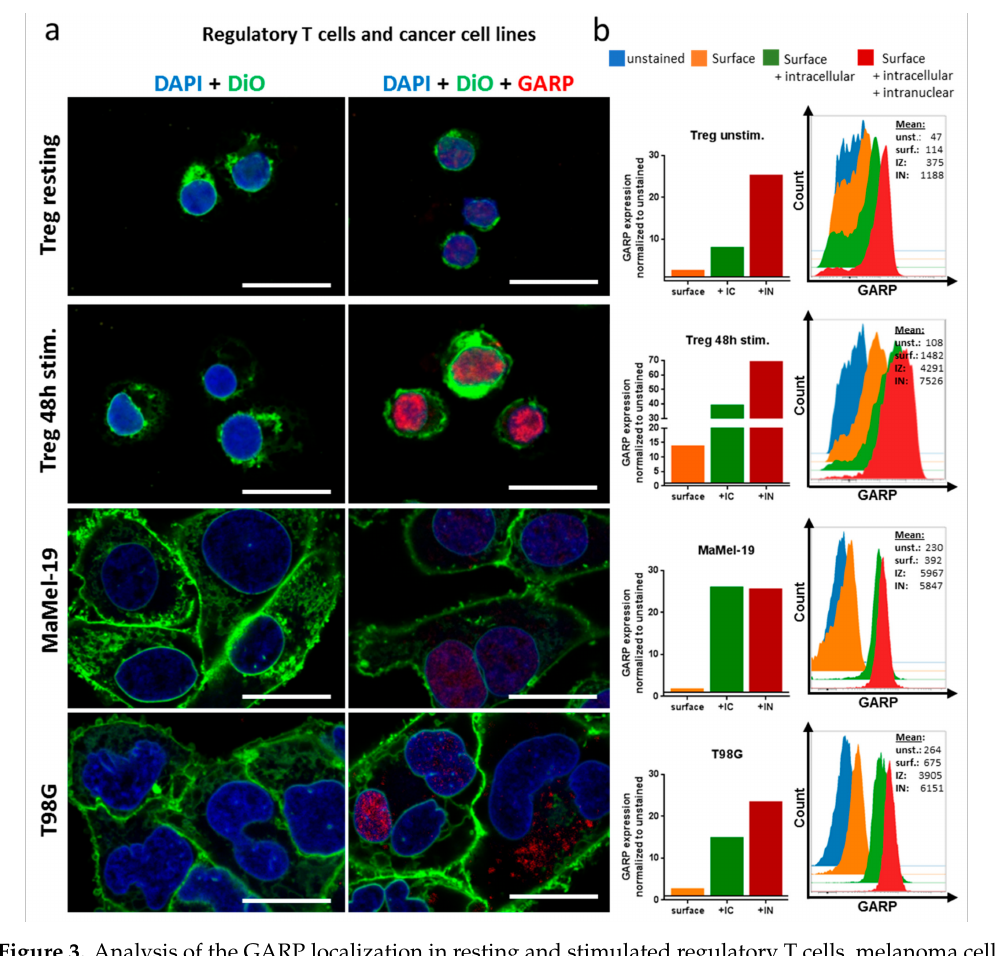
Figure 3. Analysis of the GARP localization in resting and stimulated regulatory T cells, melanoma cell line MaMel-19, and glioblastoma cell line T98G. The Treg were stimulated with 1 µ g / mL anti-CD3 mAb, 1 µ g / mL anti-CD28 mAb, and 10 IU / mL IL-2 for 48 h. ( a ) Cytoplasmatic and intranuclear localization of GARP shown in confocal images. The white bar corresponds to 20 µ m ( b ) flow cytometric analysis GARP expression on the surface; surface and intracellular (IC); and surface, IC, and intranuclear (IN) of Treg, melanoma, and GB cell lines. Means were normalized to the unstained